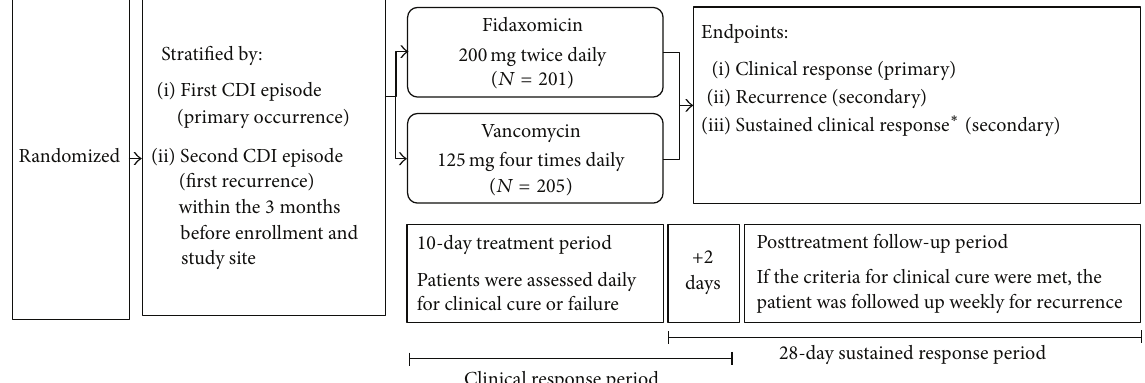
Figure 1: Study design. ∗ Sustained clinical response was defined as clinical cure without subsequent recurrence at the final trial assessment (36–40 days after